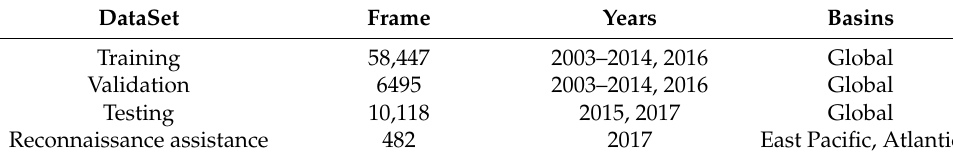
Table 3. TC sample sizes for different dataset in different